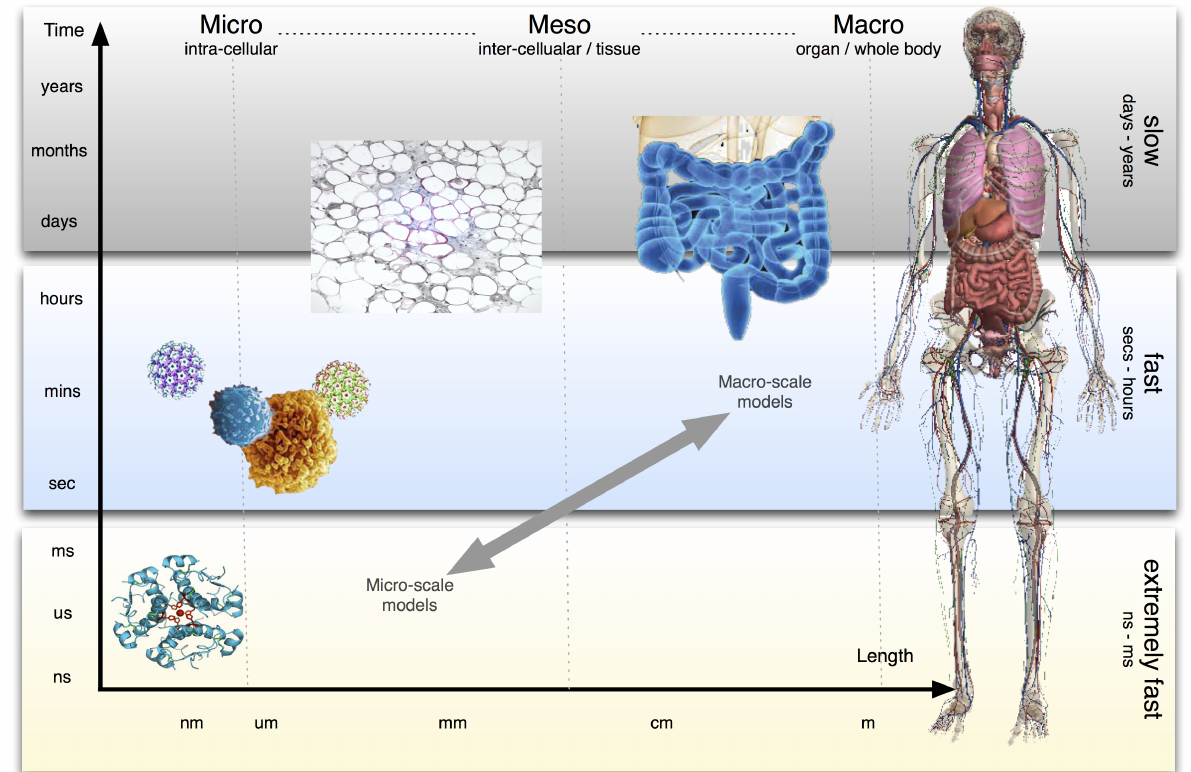
Figure 4. T2D is a complex disease and its onset and progression cover different space-time scales, from molecular events (milliseconds) up to organ deterioration (years), taking into account the contribution of the individual genetic traits. MISSION-T2D project aims to cover and integrate models at all these levels, fully supporting the VPH initiative that aims to develop a computational framework to investigate the human body as a whole in health and disease